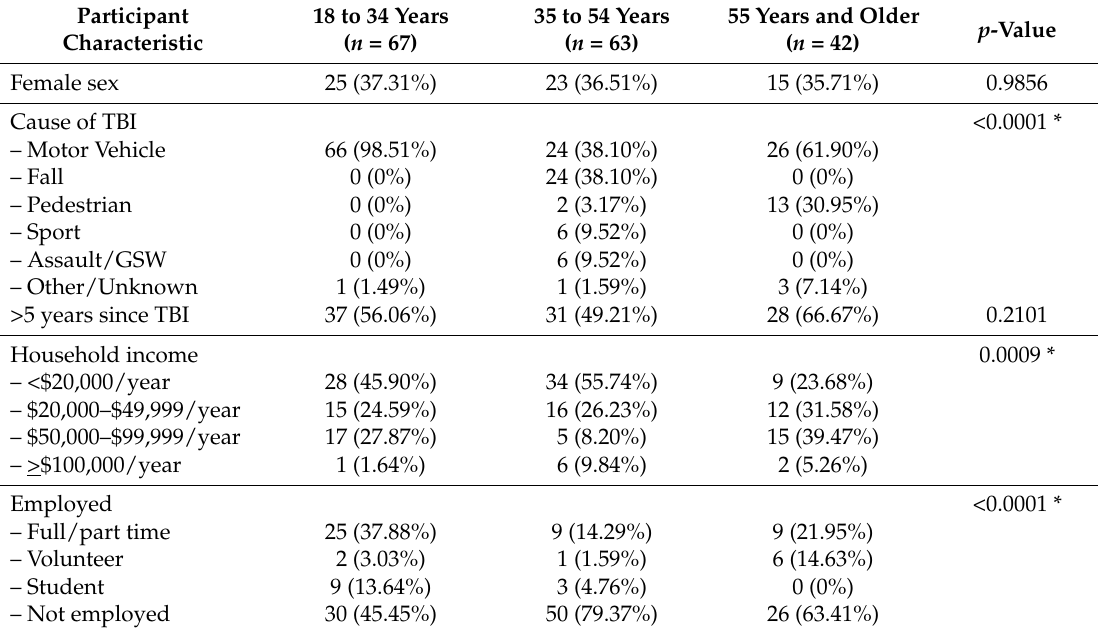
Table 1. Demographics Values are total